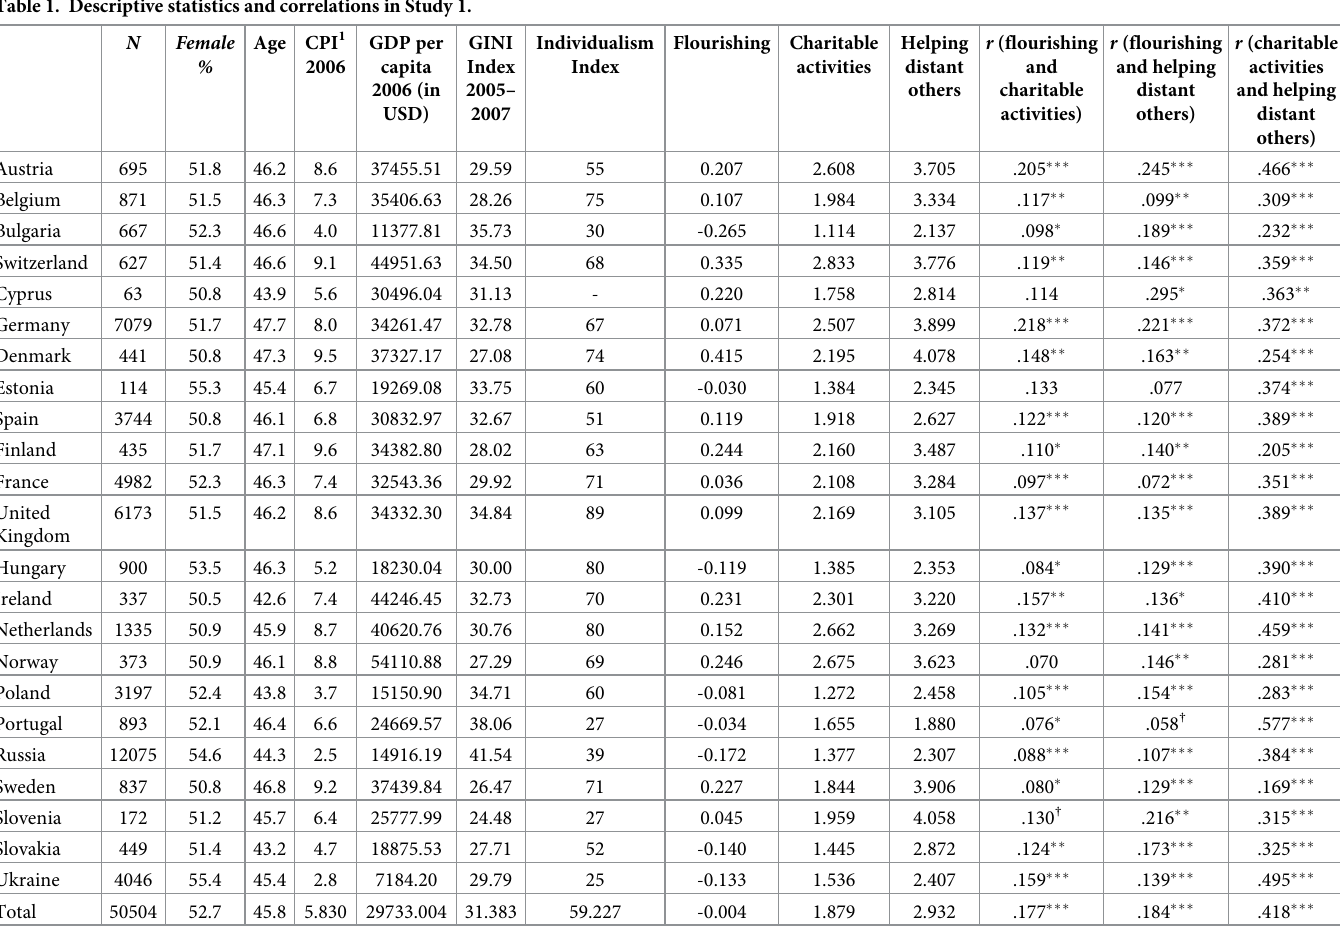
Table 1. Descriptive statistics and correlations in Study